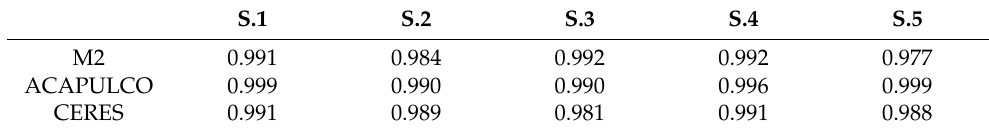
Table 8. OC comparison between our M2 model, ACAPULCO and CERES.